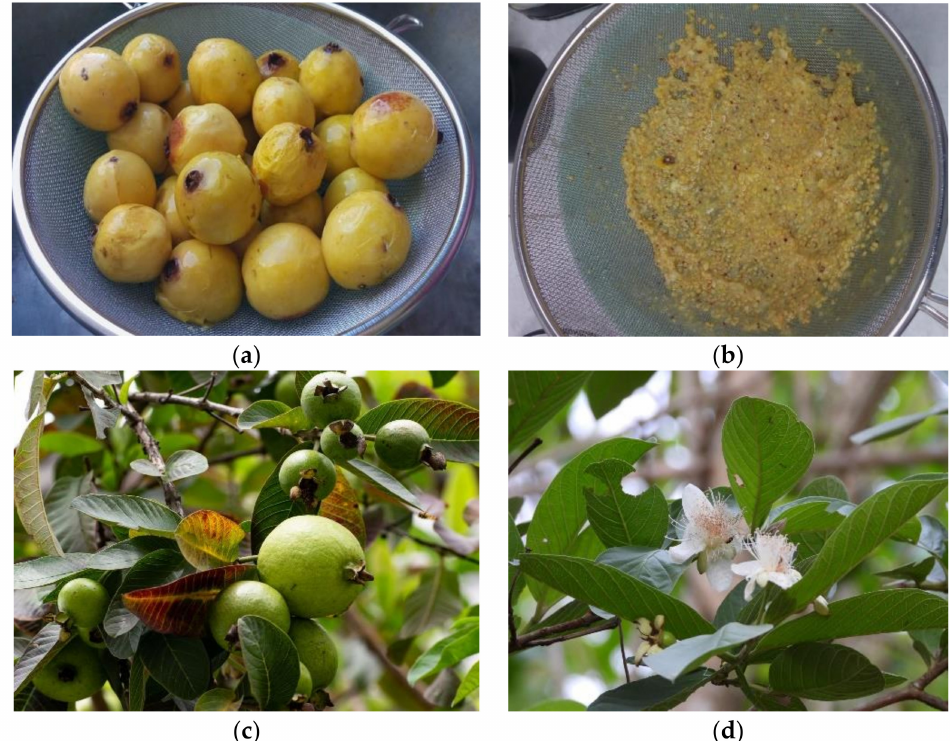
Figure 1. Description of guava plant ( P. guajava L): ( a ) Fruit, ( b ) waste or by-products, ( c ) guava plant, and ( d ) flower and